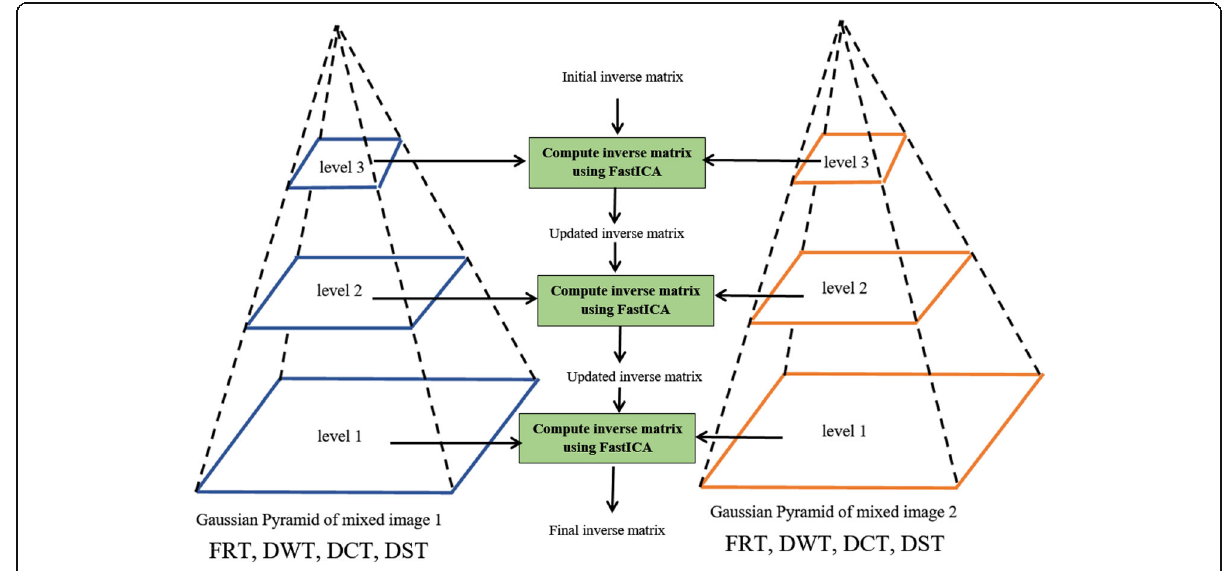
Fig. 6 Block diagram of the proposed image separation